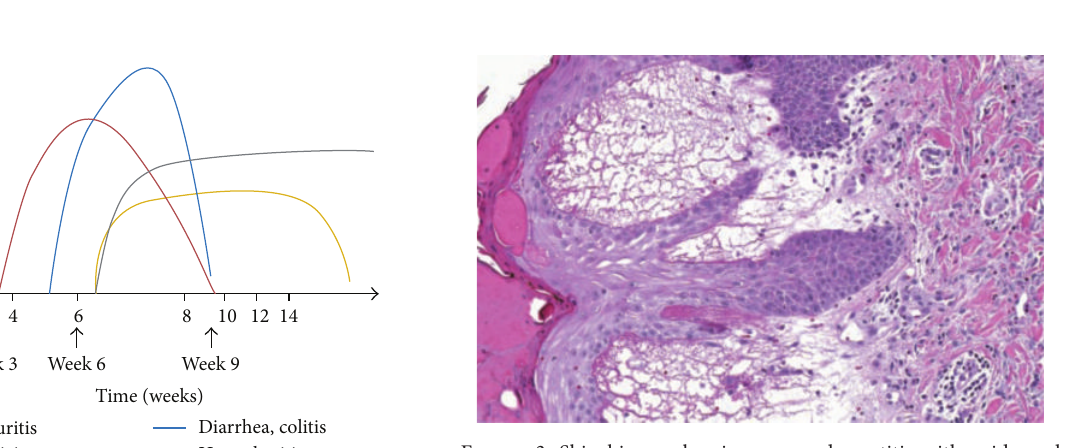
Figure 3: Skin biopsy showing severe dermatitis with epidermal spongiosis, papillary dermal edema, and a prominent inflammatory infiltrate in both the superficial and deep dermis [12]; reproduced with permission from Phan et al. 2003